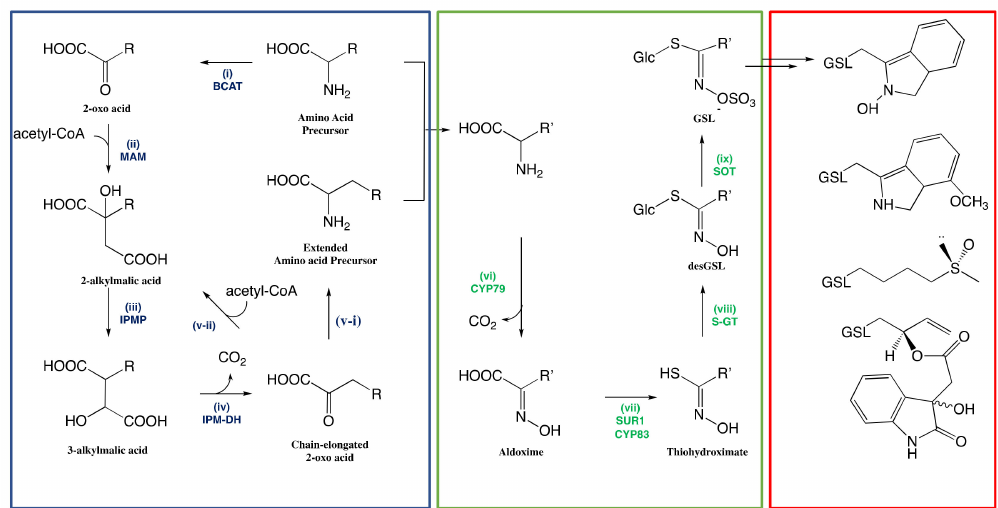
Figure 2. Three separate phases of glucosinolate biosynthesis: R indicates the variable amino acid precursors, and R’ indicates either original or extended amino acid. The blue box indicates the chain elongation phase, the green box indicates the reconfiguration phase yielding the core structure of glucosinolate, and the red box indicates the glucosinolate side-chain modification phase of the glucosinolate core structure with some examples from Table 2. The figure was adapted from the biosynthesis of GSL proposed by Graser et al.